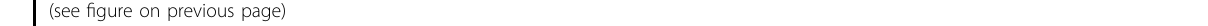
Fig. 5 Integrative analysis of proteome and metabolome. a Four clusters of proteins with different protein and metabolite expression dynamics for the SC and LC groups computed using Mfuzz (one-way ANOVA, B-H adjusted P -value < 0.05). b Pathways enriched using MetaboAnalyst ( P - value < 0.05). c The annotated proteins are shown in the four networks. For each circle, the right/left half panel shows the expression time-series in the LC/SC group (two-way ANOVA; * P < 0.05; ** P < 0.01; *** P < 0.001). Black asterisks indicate a signi fi cant variance over 8 – 9 time points in the SC or LC groups; the red asterisks represent the difference between the LC and SC groups; the blue asterisks represent the interaction difference between time points and the LC and SC groups. The outermost ring represents the maximum abundance of the proteins/metabolites, between the SC and LC groups, across nine time points for proteins and eight time points for metabolites. The different backgrounds represent the classi fi cation of the